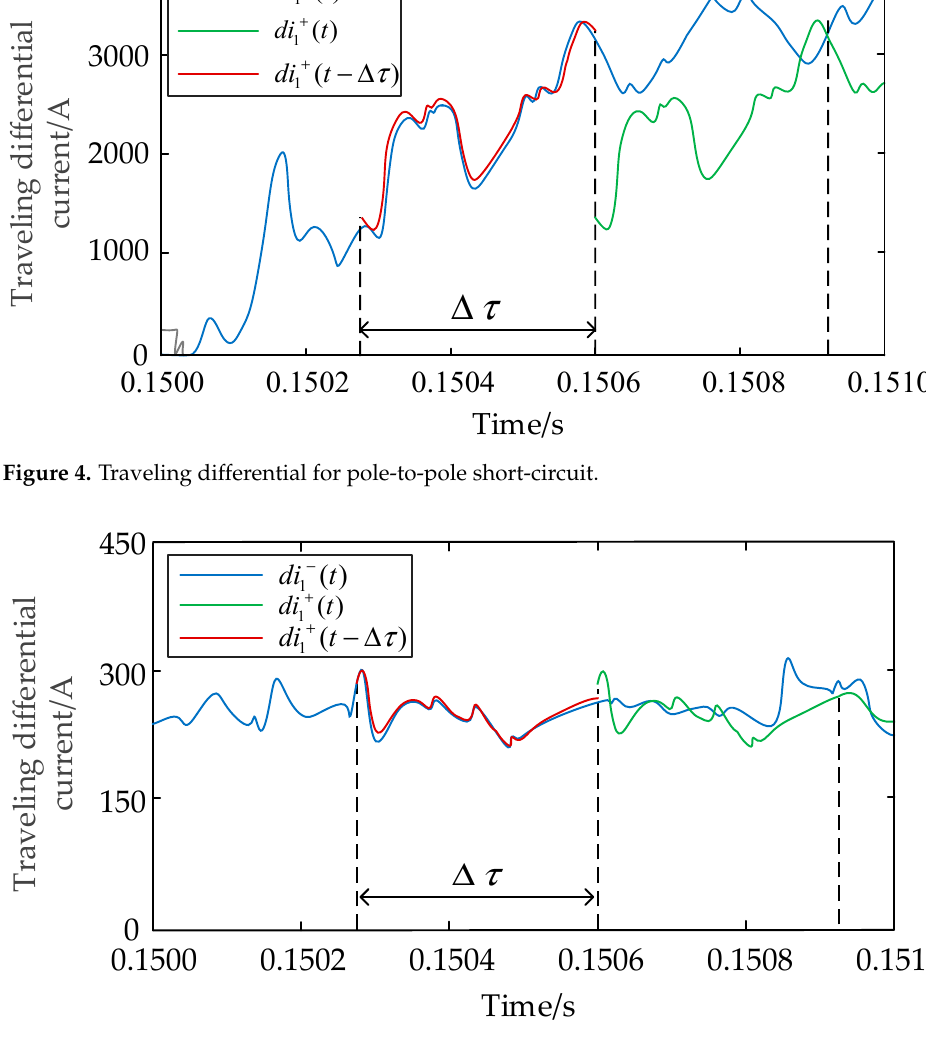
Figure 5. Traveling differential for positive pole-to-ground short-circuit.